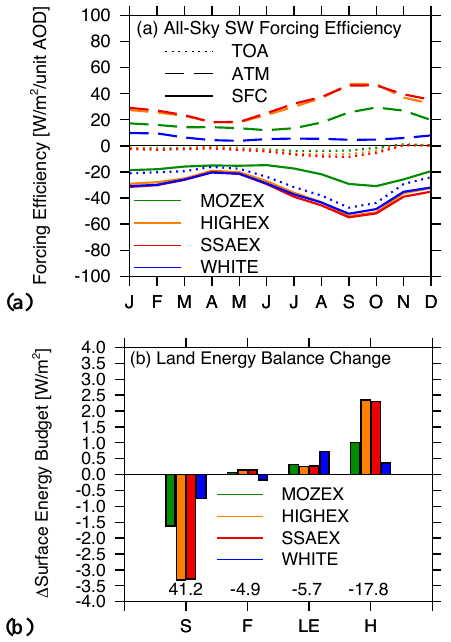
Fig. 4. (a) Monthly-mean area-averaged (3 ◦ N–37 ◦ S, 19 ◦ W– 50 ◦ E) all-sky (cloudy) SFC, ATM, and TOA short-wave (SW) forc- ing efficiency [Wm − 2 per unit AOD], where TOA = SFC + ATM. (b) ASO area-average equilibrium change in S , F , LE , and H fluxes at the surface relative to CTRL from Eq. (3) [Wm − 2 ]; positive (negative) changes warm (cool) the surface. Area-average values for CTRL are listed along the lower portion of panel